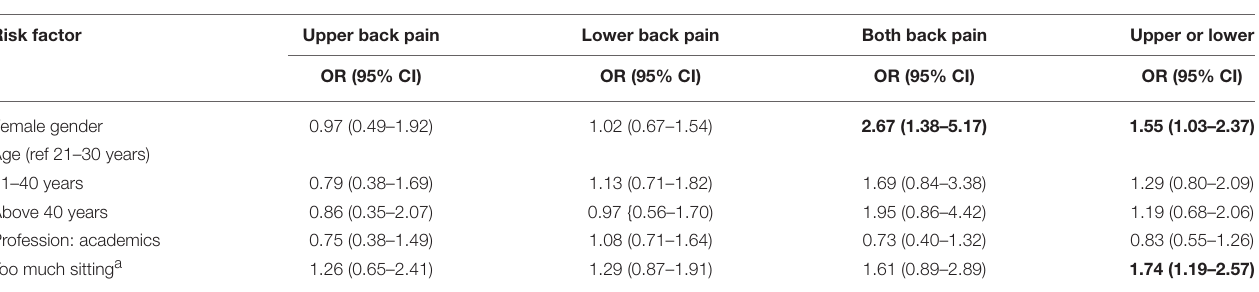
TABLE 4 | Association between back pain and too much sitting after adjusting for age, gender, and profession. Risk factor